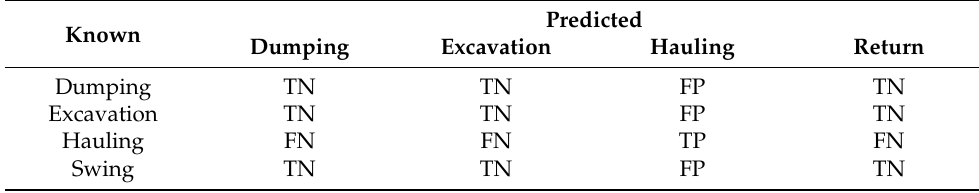
Table 3. Confusion matrix for activity “hauling”.